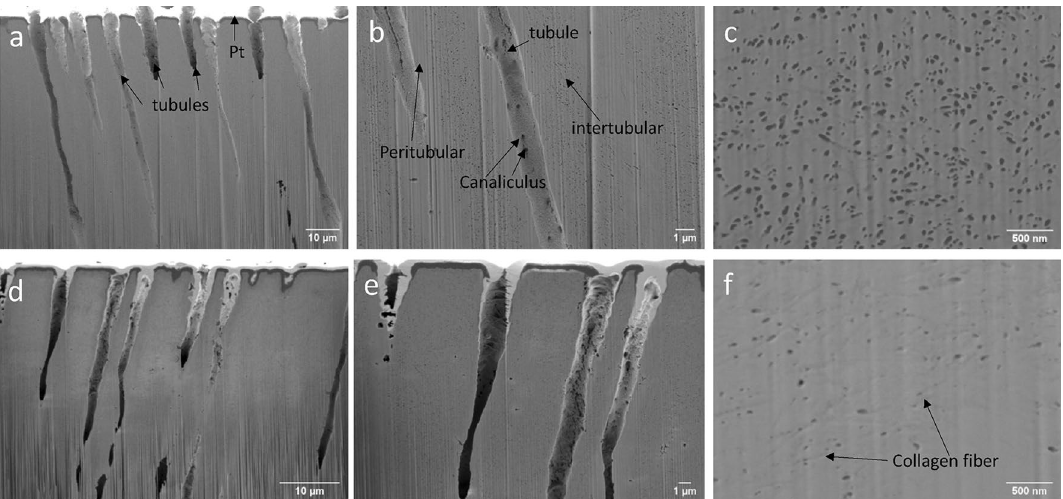
Figure 3. SEM images of the non-stained and stained dentine disk: ( a ), ( b ), and ( c ) are the cross sections of the non-stained dentine disk at different magnifications; ( d ), ( e ), and ( f ) are the cross-sections of the stained dentine disk at different